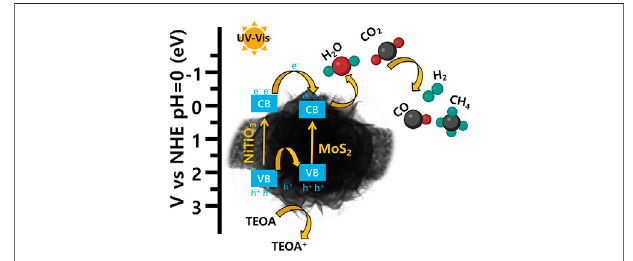
FIGURE 8 | Schematic illustration of the proposed charge transfer mechanism for CO 2 photoreduction under ultraviolet-visible light illumination on NiTiO 3 /MoS 2